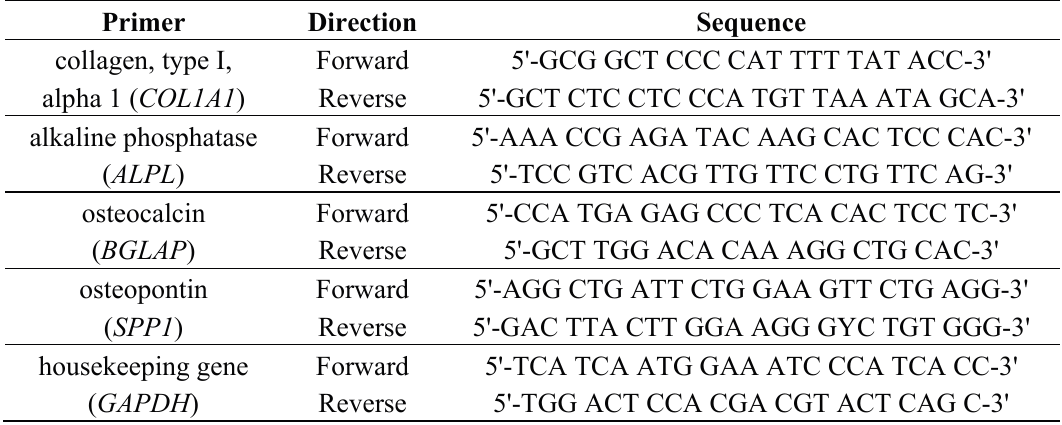
Table 1. Oligonucleotide sequences of osteogenic